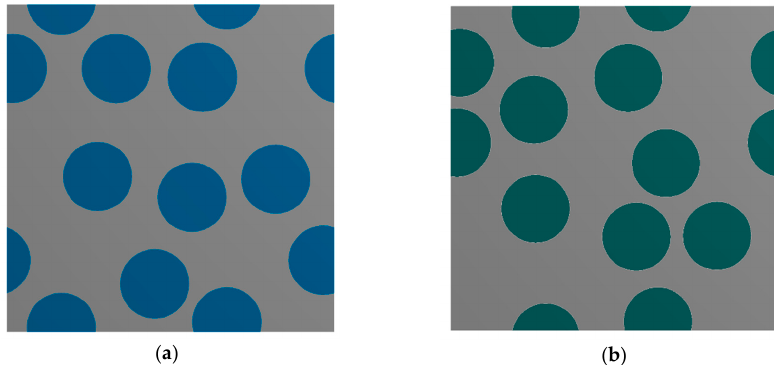
Figure 5. Geometrical models of the composite microstructure: ( a ) Material 1; ( b ) Material 2.